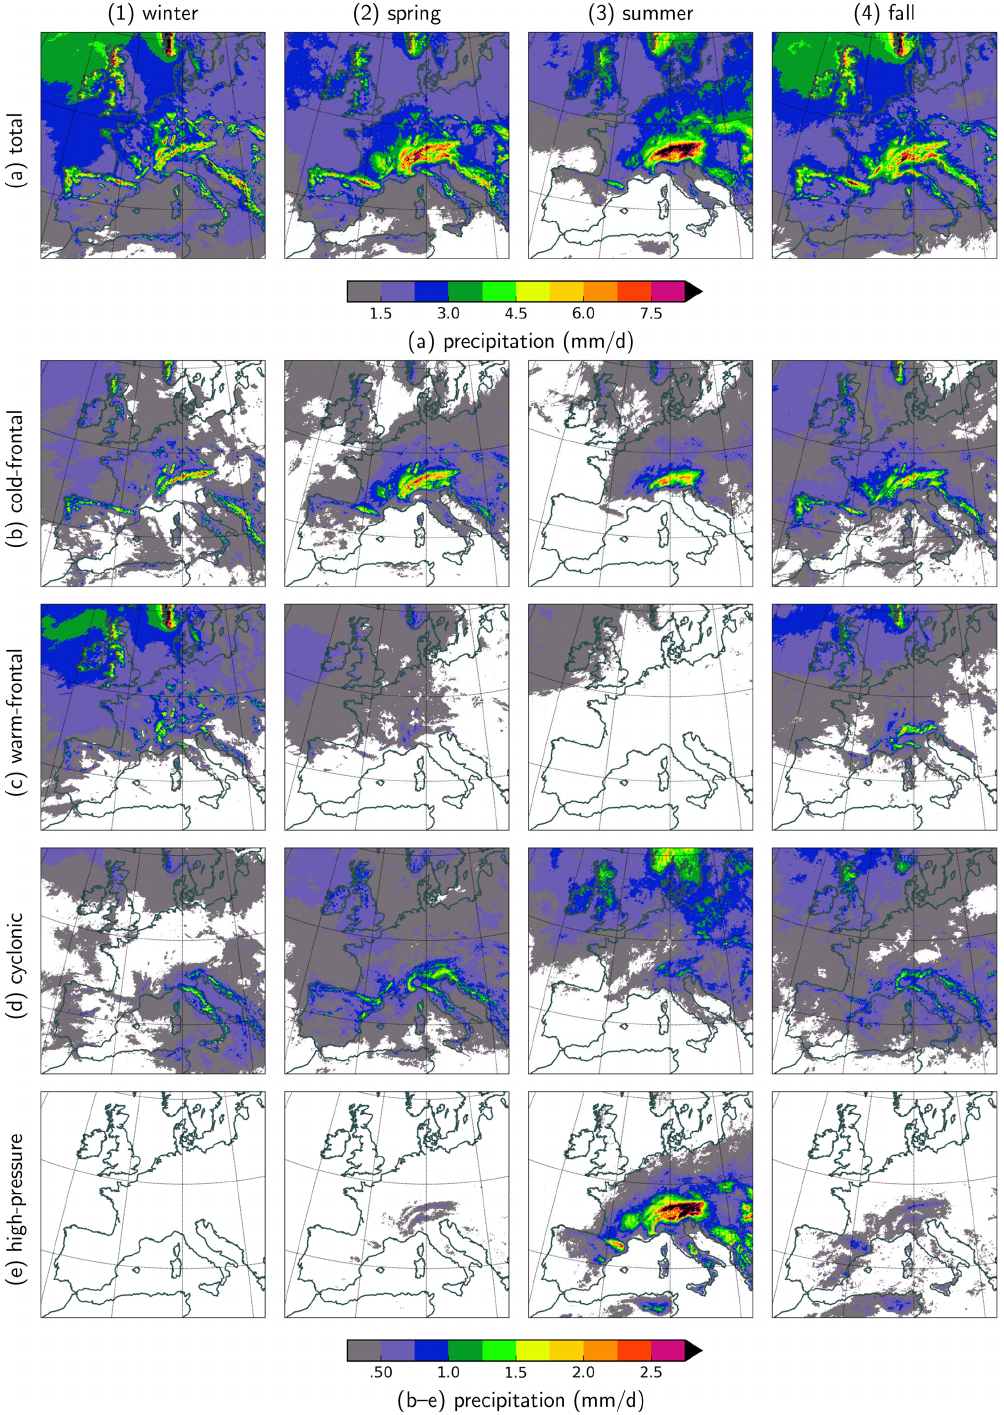
Figure 8. Mean daily precipitation during (1–4) each season of the 9-year period 2000–2008 (a) overall and (b–e) of selected front–cyclone- relative